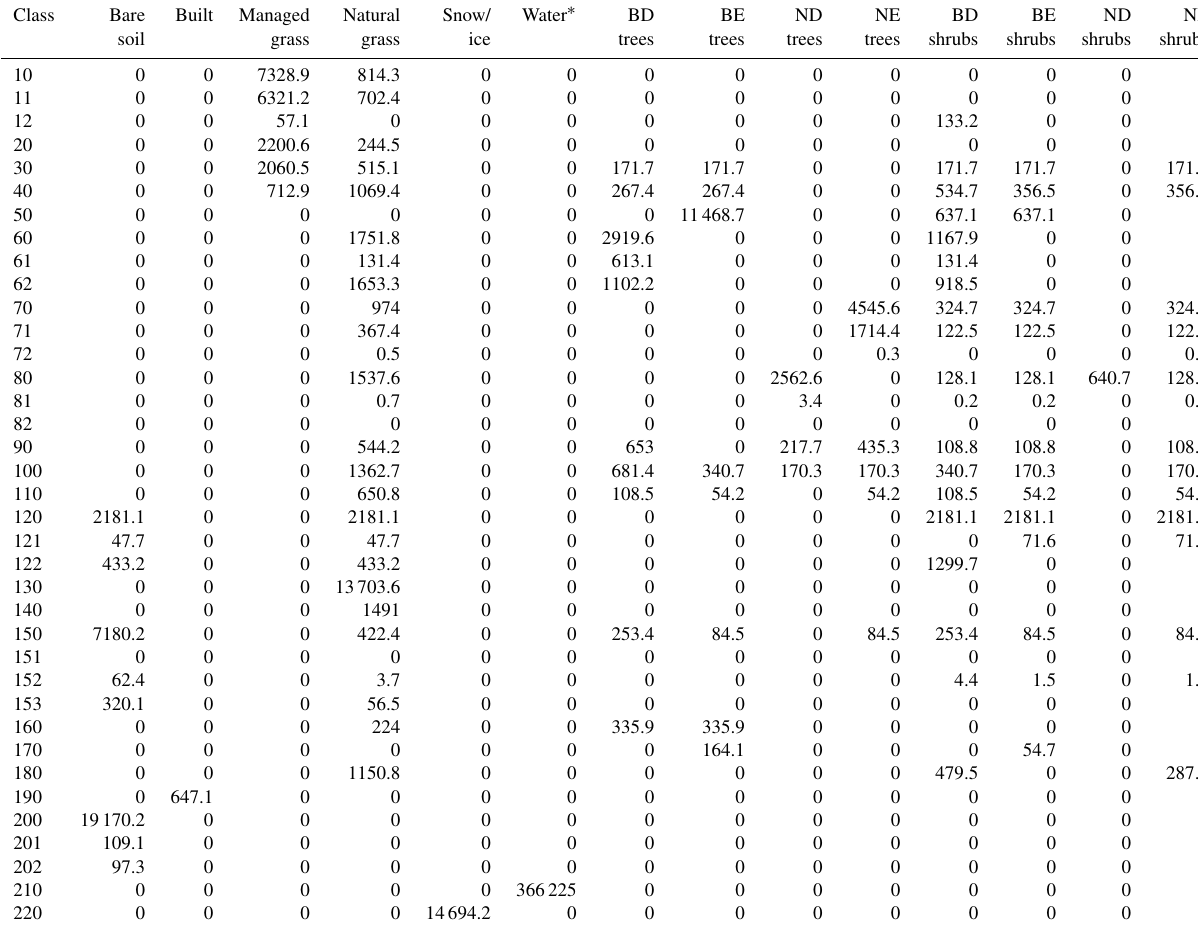
Table A1. Global areal cover (1000km 2 ) of each PFT by land cover class for 2010 based on the most recent version of the global CWT applied to v2.0.8 of the CCI MRLC